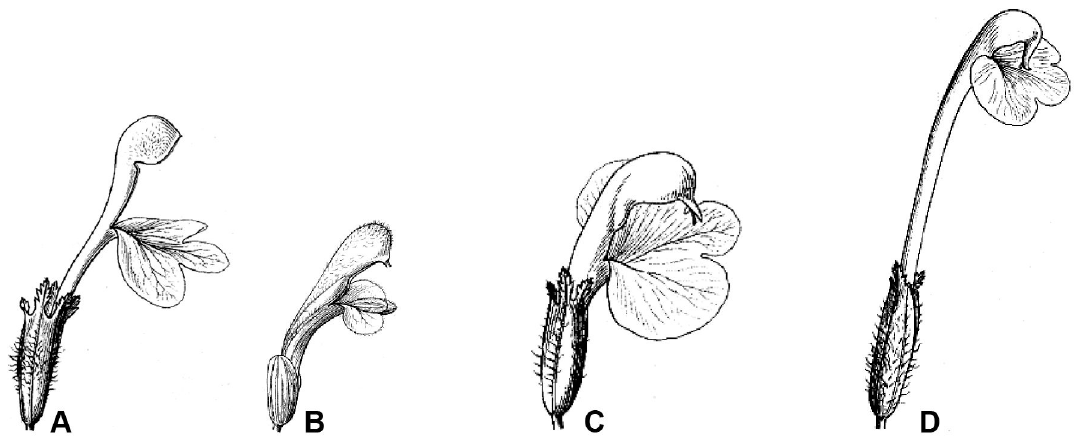
Figure 1. Four general corolla types in Pedicularis section Cyathophora (Redrawn from Tsoong [14]). (A) short tubular corolla with a beakless and toothless galea ( P. cyathophylloides ); (B) short tubular corolla with a toothed galea (P. rex subsp. rex ); (C) short tubular corolla with a beaked galea ( P. superba ); and (D) long tubular corolla with a beaked galea ( P. cyathophylla ). doi: